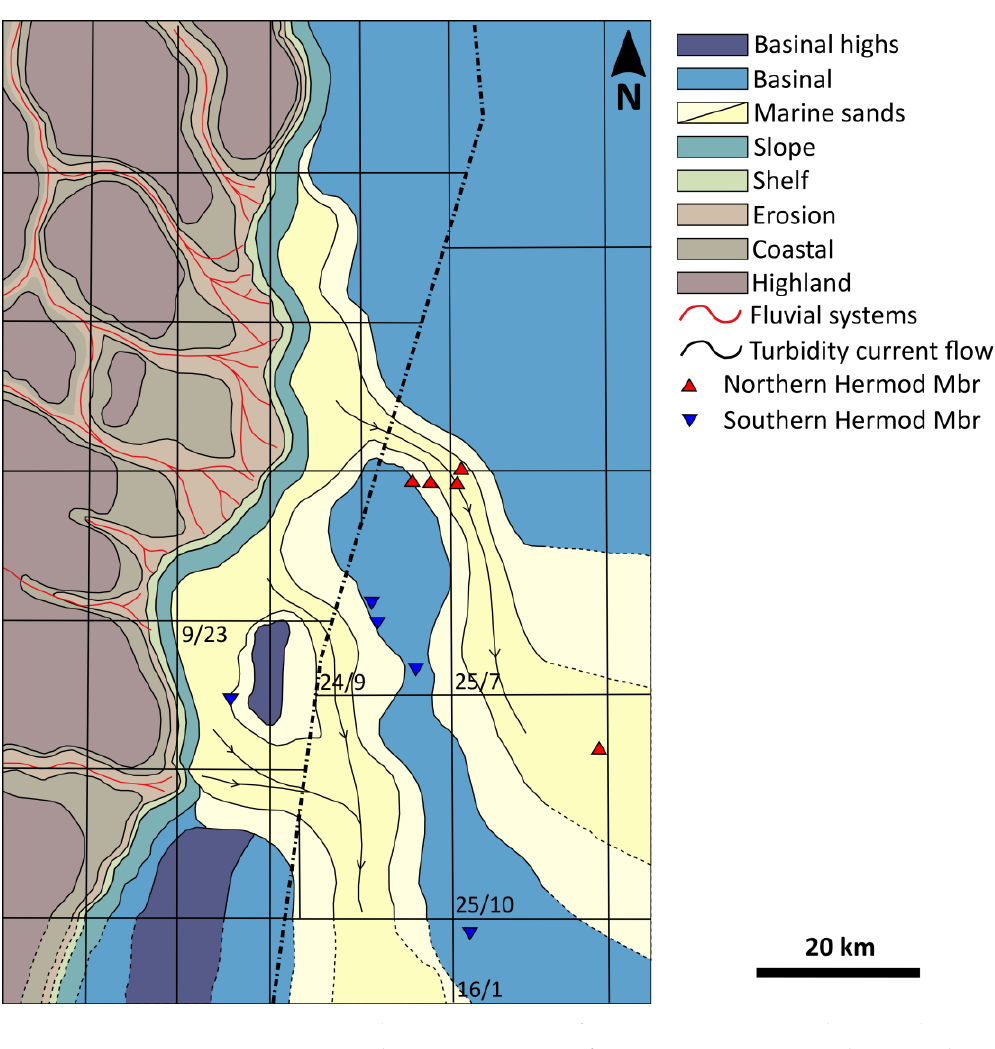
Figure 3. Depositional environment map of T48 sequence, corresponding to early Eocene (Ypresian). Key wells penetrating Hermod S2 Mbr are highlighted. Red triangles denote northern well group; blue inverted triangles denote southern well group (see text for definitions). Modified after Dixon & Pearce [41].